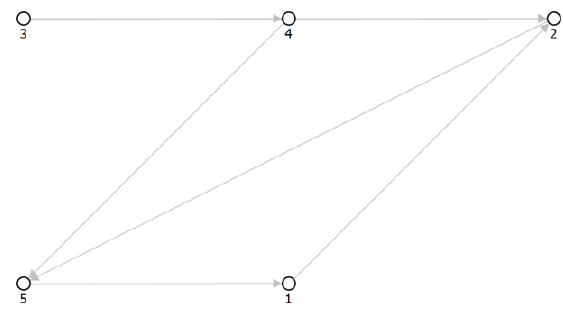
Figure 4. Topological relationships among five scans